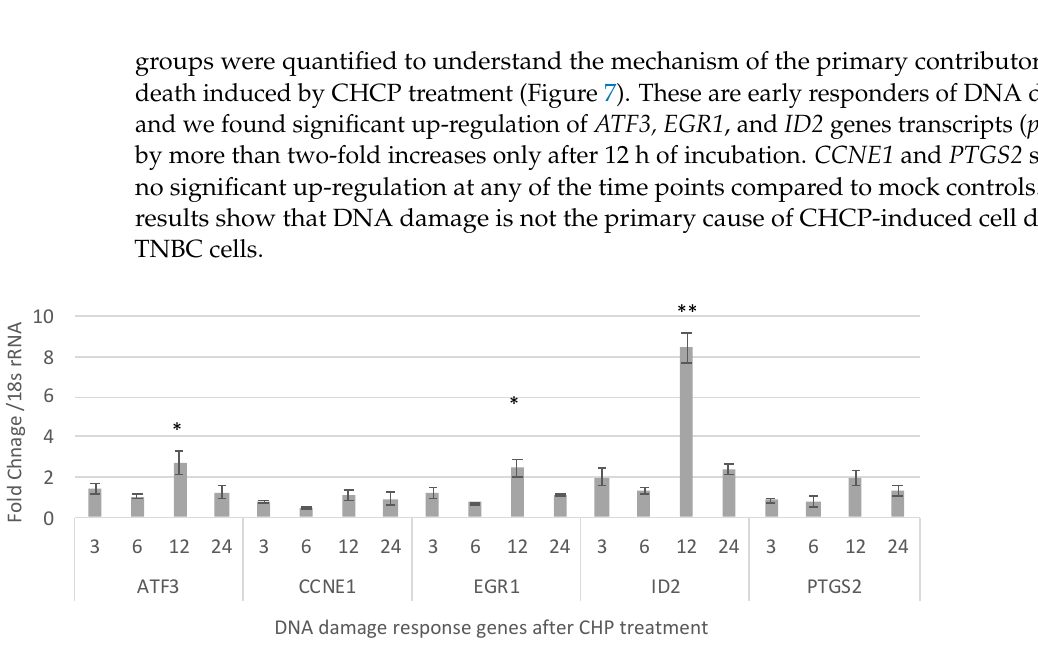
Figure 7. Fold-changes in DNA damage response gene transcripts ATF3, CCNE1, EGR1, ID2 and PTGS2 genes compared to mock controls in MDA-MB-231 cells post-CHCP treatment at different incubation time points (3, 6, 12, & 24 h). Statistical analysis was performed using Student’s t -test. * p < 0.005; ** p < 0.001.